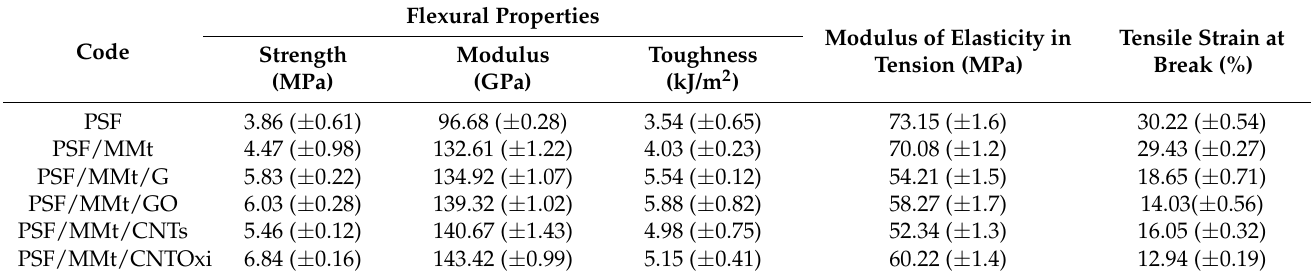
Table 3. Flexural modulus of elasticity in tension and tensile strain at break of PSF and its related carbon-based nanocomposites.